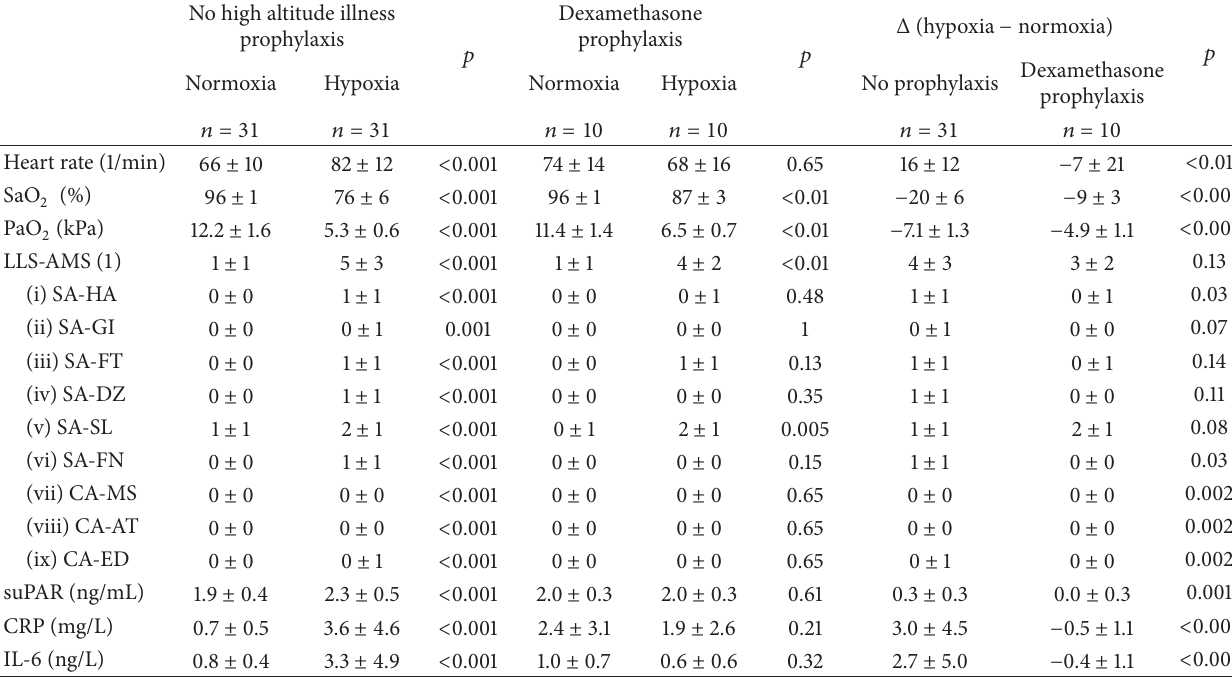
Table 1: The effect of acute hypoxic exposure on inflammatory markers and physiological parameters with and without dexamethasone prophylaxis.